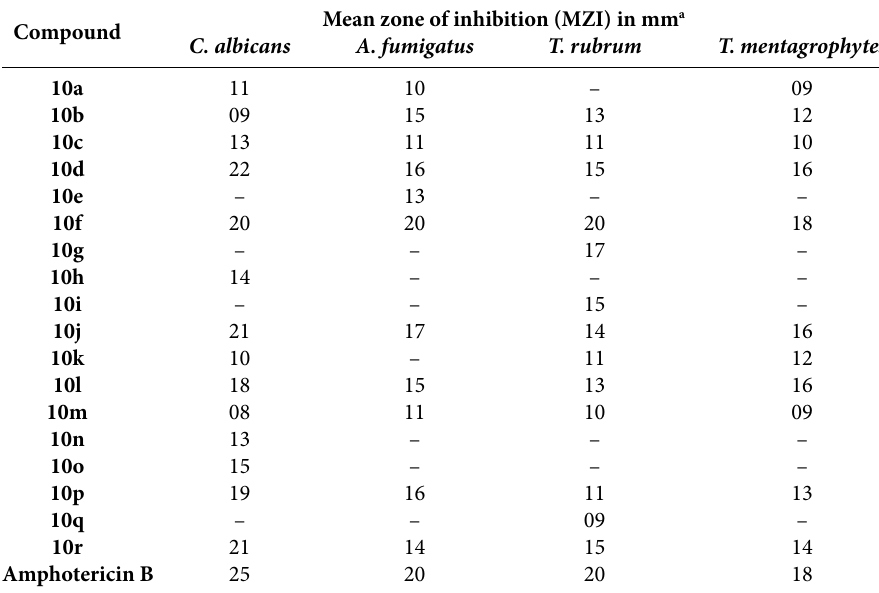
Table 3. Inhibitory zone diameters (mm) of 10a – r against tested fungal strains